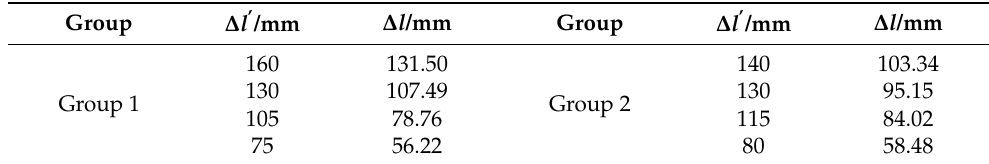
Table 1. Travel distance between the laser focus point and laser probe.